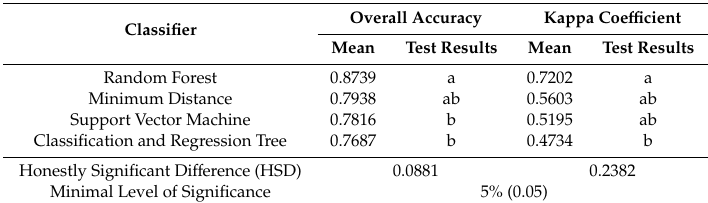
Table 7. Summary of the Tukey honestly significant di ff erence (HSD) test computed for the overall accuracy and kappa coe ffi cient.